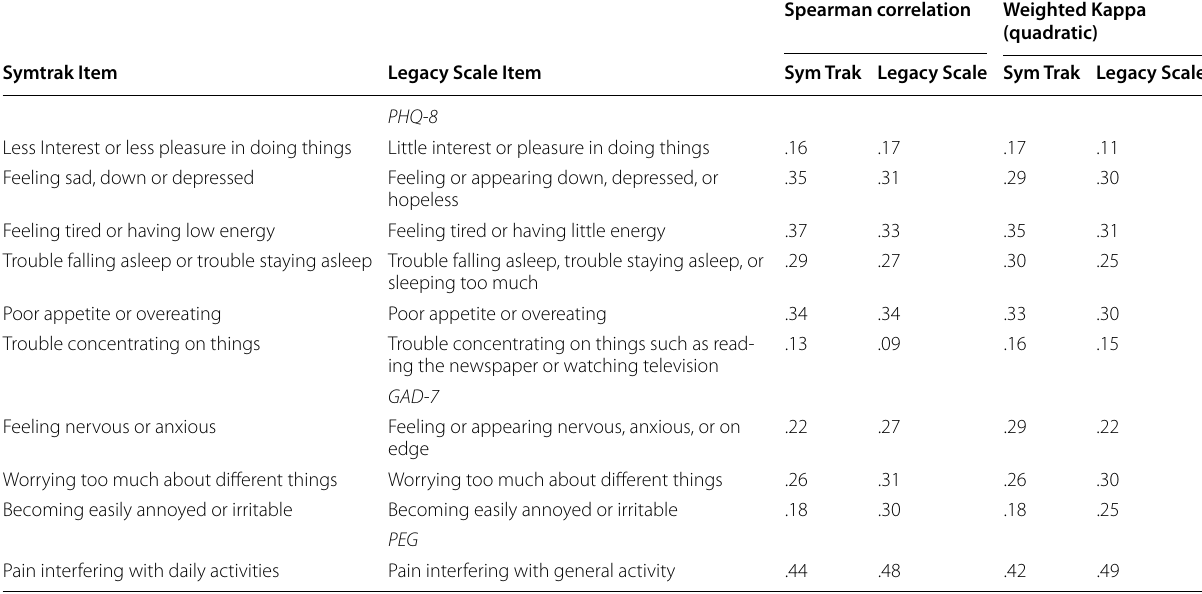
Table 5 Comparison of Patient-Caregiver Concordance on Items Common to Symtrak and Legacy